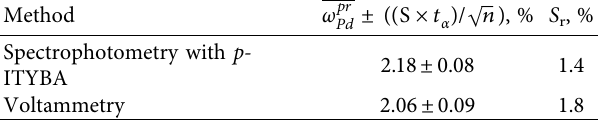
Table 4: Results of spectrophotometric determination of palla- dium(II) in a catalyst using p-ITYBA ( S p -ITYBA � 7.50 · 10 − 5 mol · L − 1